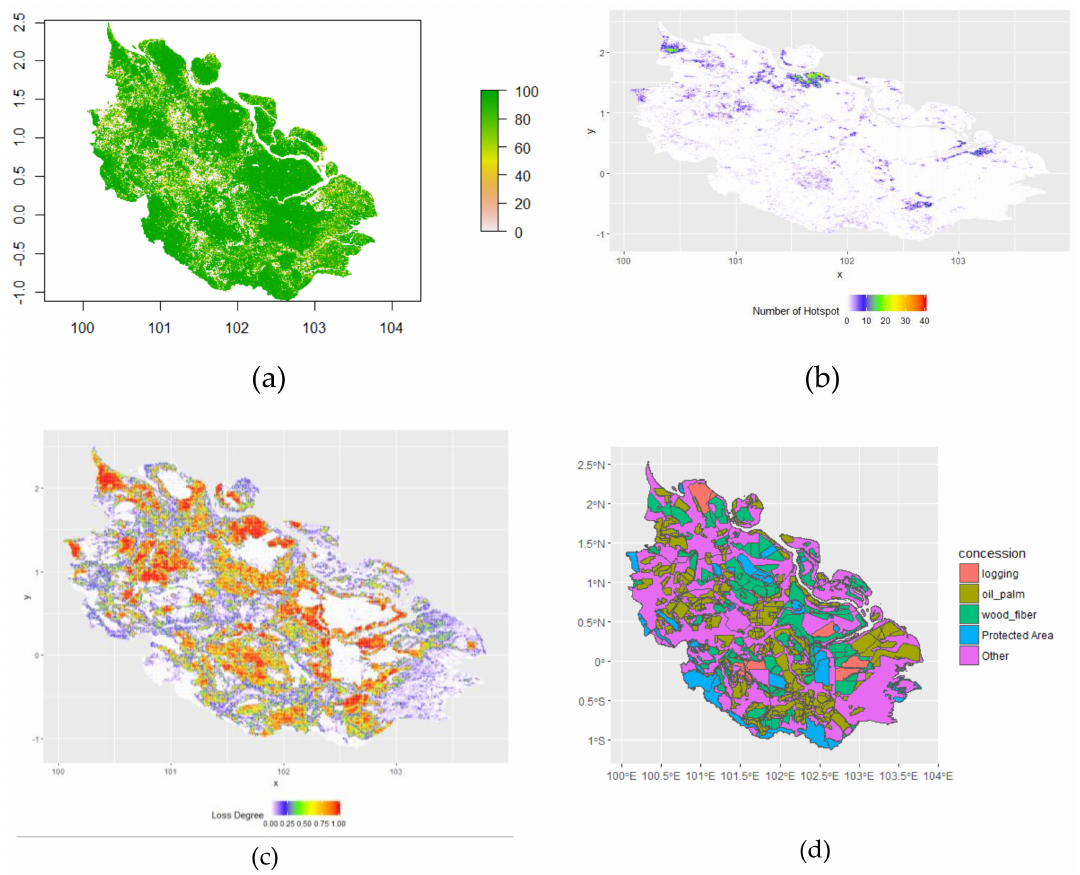
Figure 1. Land-cover and land-use in Riau Province, Sumatra, Indonesia. ( a ) Percentage canopy cover in year 2000; ( b ) Total number of high confidence fire hotspots detected between 2001 and 2012; ( c ) Fractional tree cover loss between 2001 and 2012; ( d ) Concession areas (see text for full